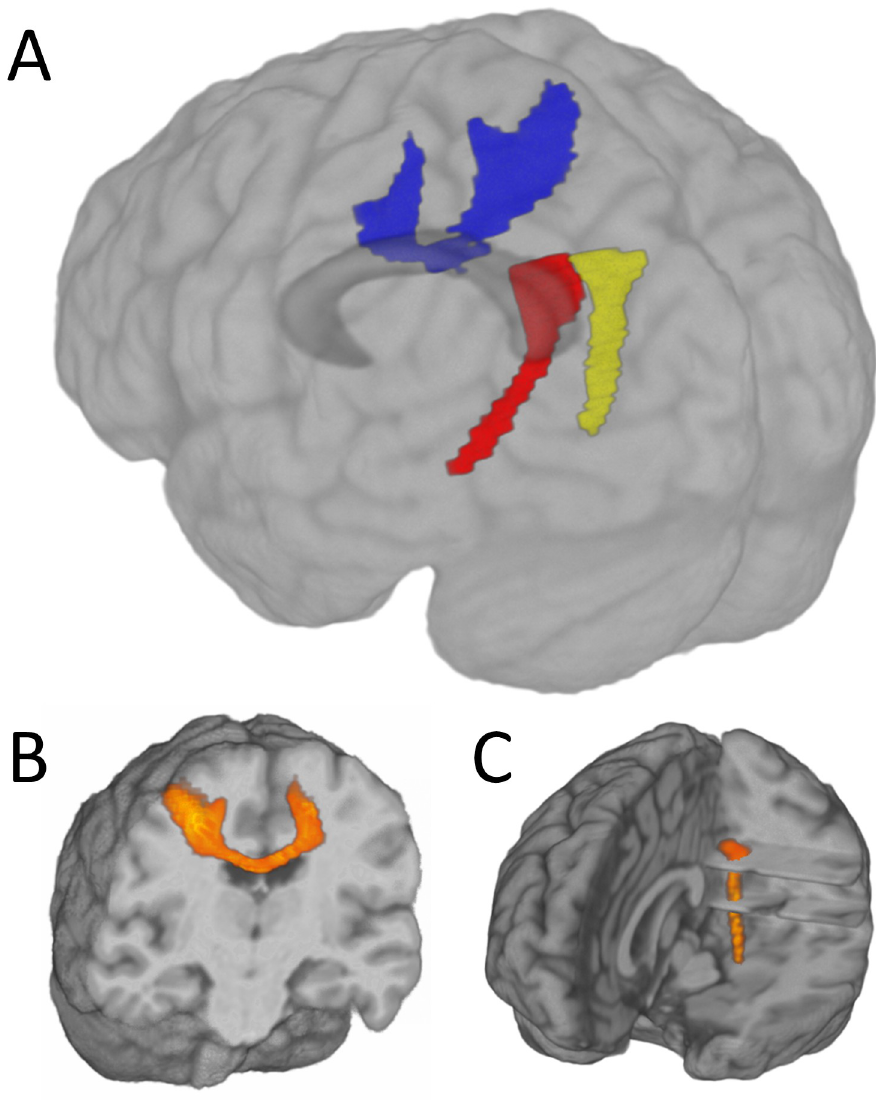
Fig 3. Example of probabilistic tracking. Individual subject probabilistic tracking results. A) Blue = transcallosal SMC, red = left hemisphere PCC-AMTL, yellow = right hemisphere PCC-AMTL track. The bottom row shows additional anatomical detail for B) the SMC and C) the left PCC-AMTL tracks. Displayed tracks are count-thresholded surfaces derived from probabilistic maps described in the text. SMC = primary sensorimotor cortices; PCC-AMTL = posterior cingulate cortex-antero-mesial temporal